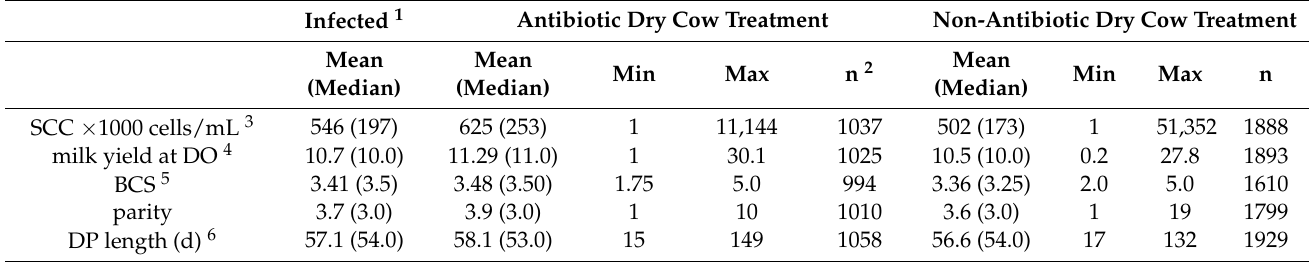
Table 1. Descriptive results for cow characteristics on quarter level for all quarters infected at DO 4 and sorted by treatment